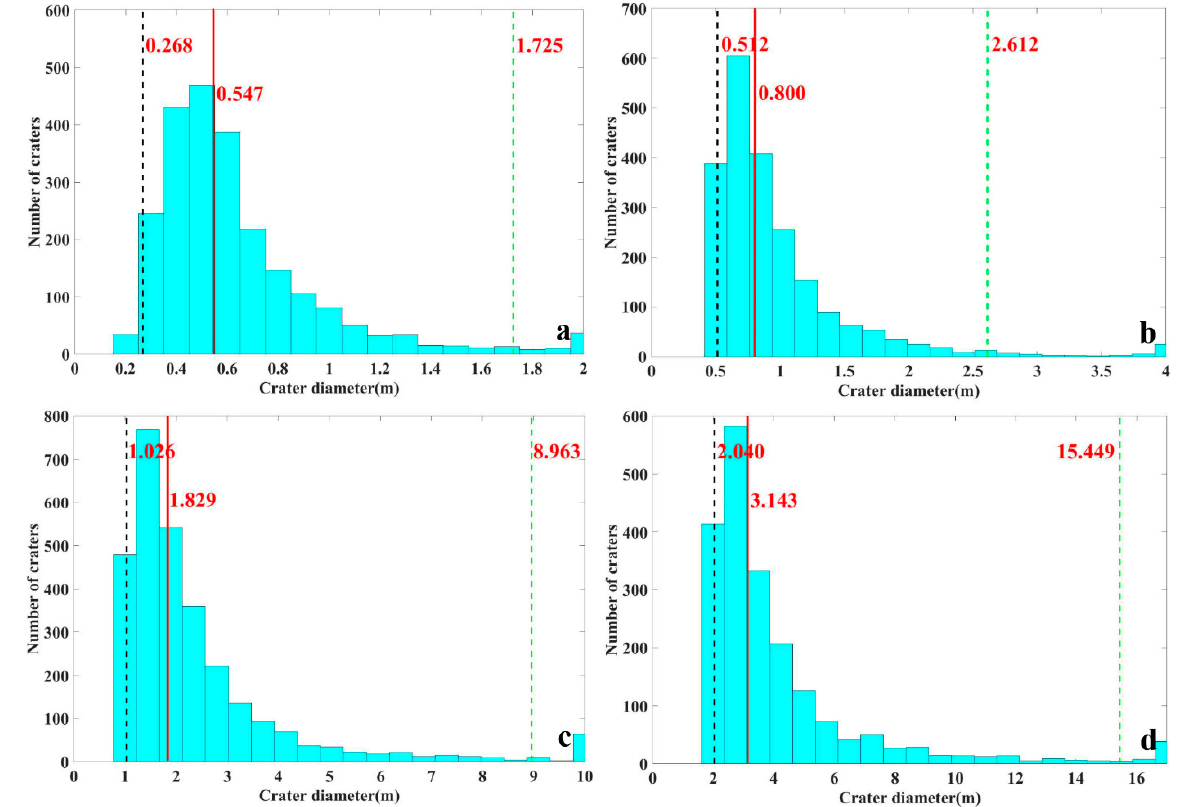
Figure 7. Histogram of the crater diameter distribution in each study region, where the red line is the median of the crater diameter distribution, and the black and the green dashed lines are the diameters corresponding to 2.5% and 97.5% of the number of impact craters, respectively. The interval between the two dashed lines corresponds to the diameter distribution of 95% of the impact craters. ( a – d ) show histograms of the crater diameter distribution of the red, yellow, aquamarine, and pink outlined areas, respectively.